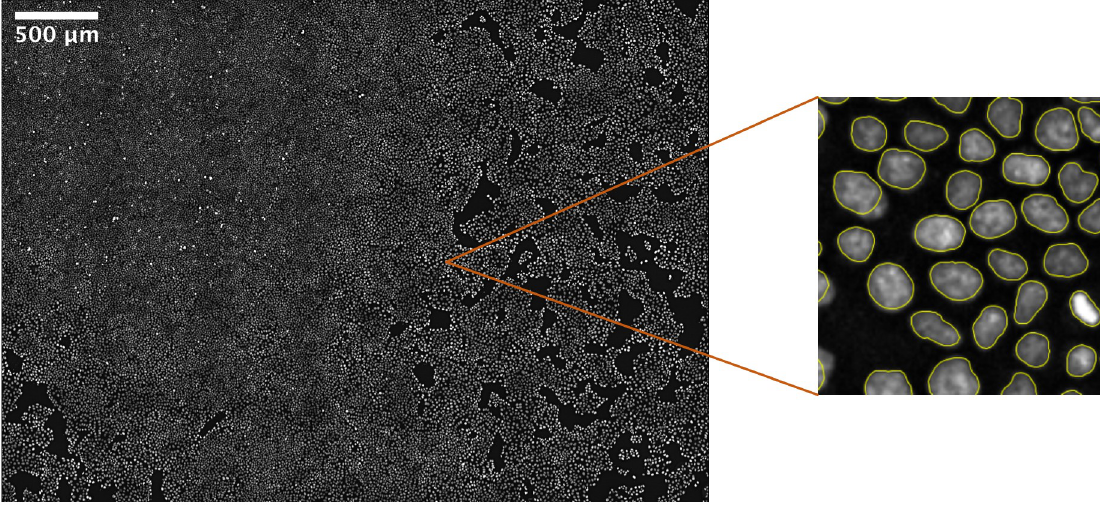
Fig 8. Large scale nuclei segmentation of a widefield microscopy image trained on an automatically annotated dataset. The image has with a view size of 4.2 mm x 3 mm containing more than 60000 single nuclei. Segmentation results are obtained within one hour, including (automatic) annotation and training with a neural